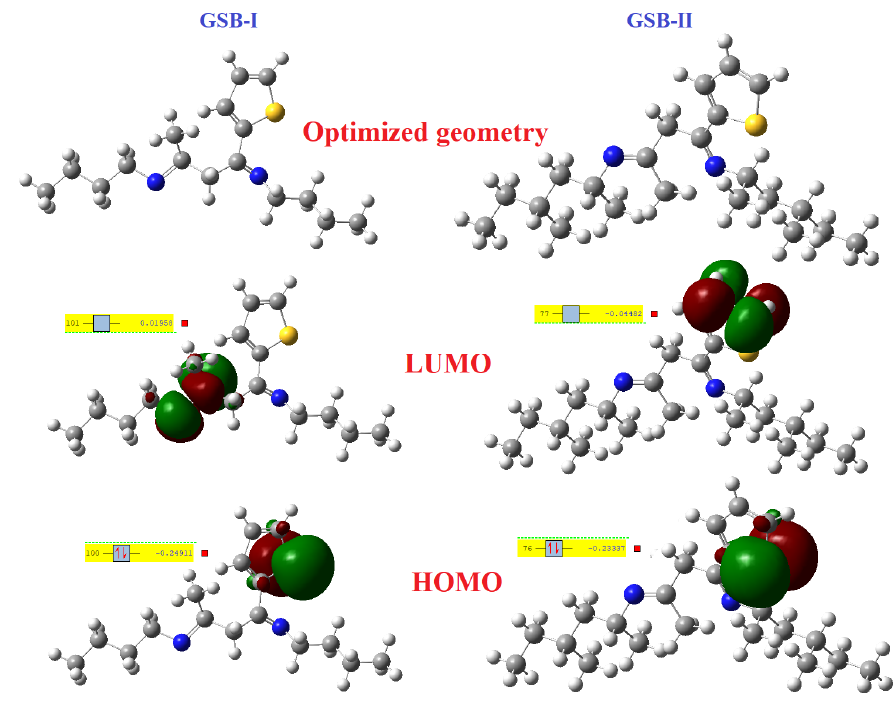
Figure 8. Optimized structures, LUMO and HOMO plots of the studied